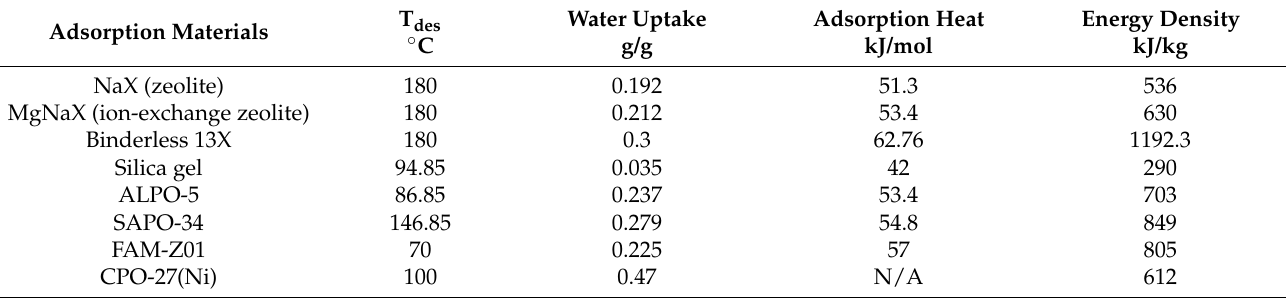
Table 6. Summary of the adsorption materials for thermal heat